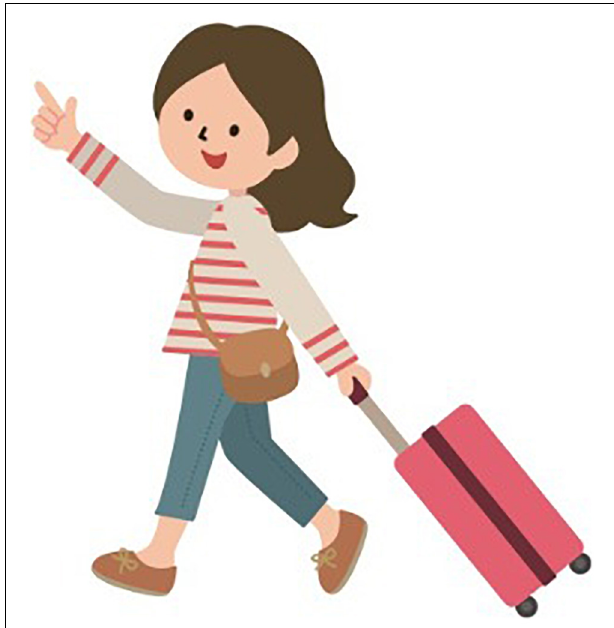
FIGURE 3 | Transformation and/or transfer of